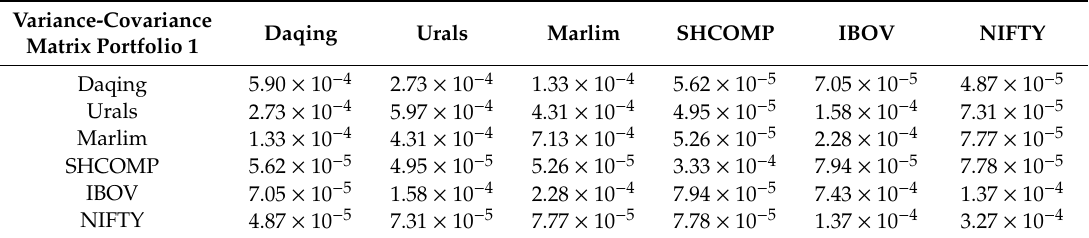
Table A25. Maximum Likelihood Variance-Covariance Matrices for portfolio 1: Daqing, Urals, Marlim, SHCOMP, IBOV, NIFTY. Elaborated by authors with data from Bloomberg.